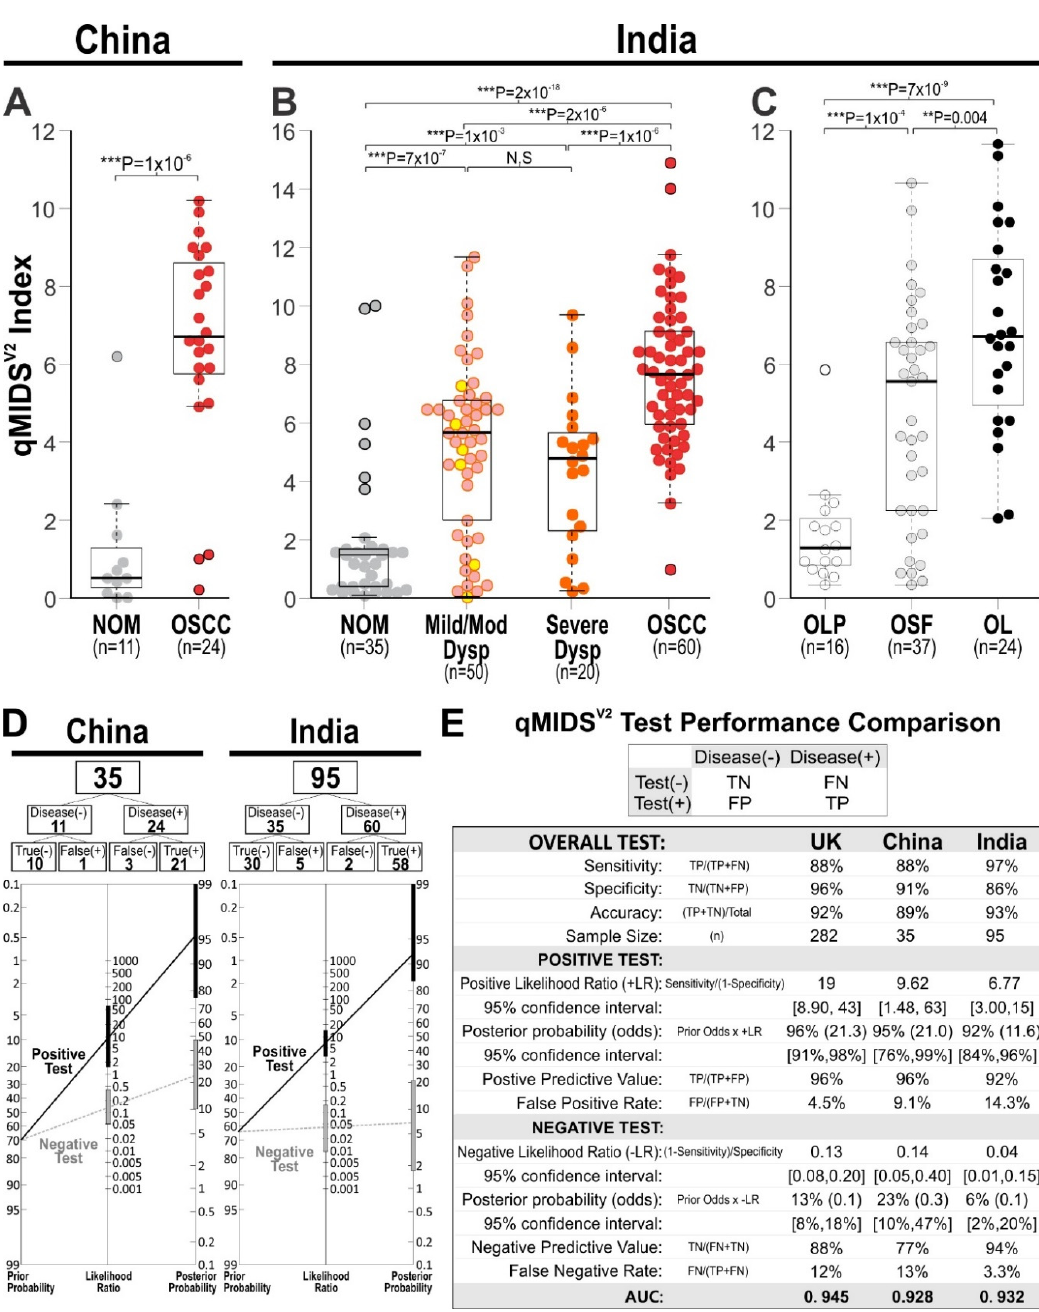
Figure 4. Multi-cohort qMIDS V2 diagnostic performance comparisons across geographically and ethnically distinct OSCC cohorts. ( A , B ), China cohort samples (snapped frozen samples): ( A ), normal oral mucosa (NOM; grey) and oral squamous cell carcinomas (OSCC; red). Student’s t-test p -value is indicated within the panel. ( B , C ), Indian cohort samples (FFPE): ( B ), Samples were grouped according to histopathology grading (WHO 2017): NOM, Mild (yellow)/Moderate (pink) Dysplasia (Dysp), Severe (orange) Dysplasia and OSCC (red). C, Oral lichen planus (OLP), submucous fibrosis (OSF) and dysplastic oral leukoplakia (OL) were compared. Outliers are indicated by black outlined symbols and t-test p -values are indicated above each chart. ( D ), Diagnostic test performance were compared between China and India OSCC cohort data obtained from ( A , B ). ( E ), Diagnostic test performance table for OSCC comparing between UK (extracted from Figure 3), China and India. TN, true negative; FN, false negative; FP, false positive; TP, true positive.